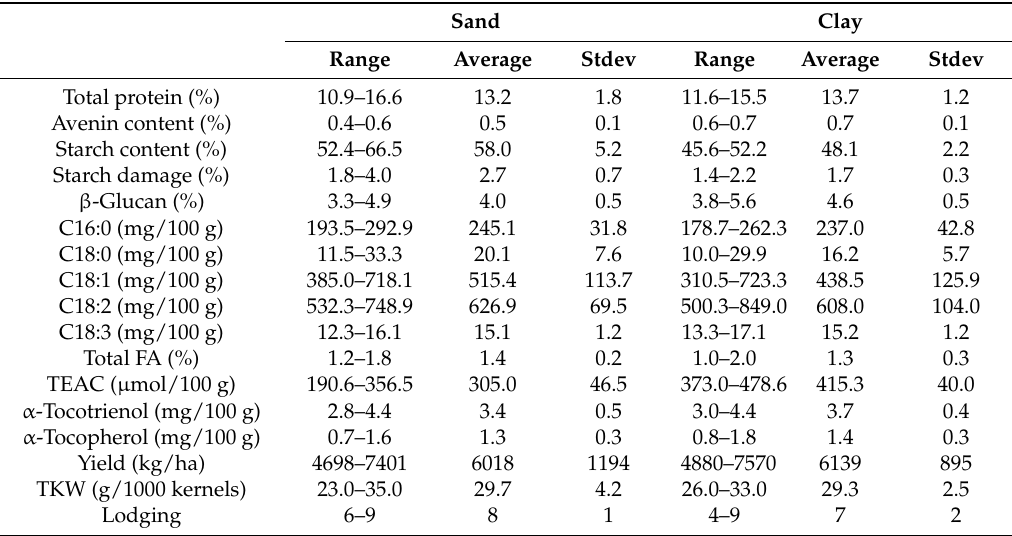
Table 1. Values for health-related nutritional compounds and field characteristics of ten oat varieties grown in sand and clay